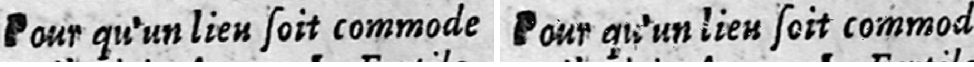
Figure 3. Ink degradation on an old document. ( Left ) original image. ( Right ) degraded image.